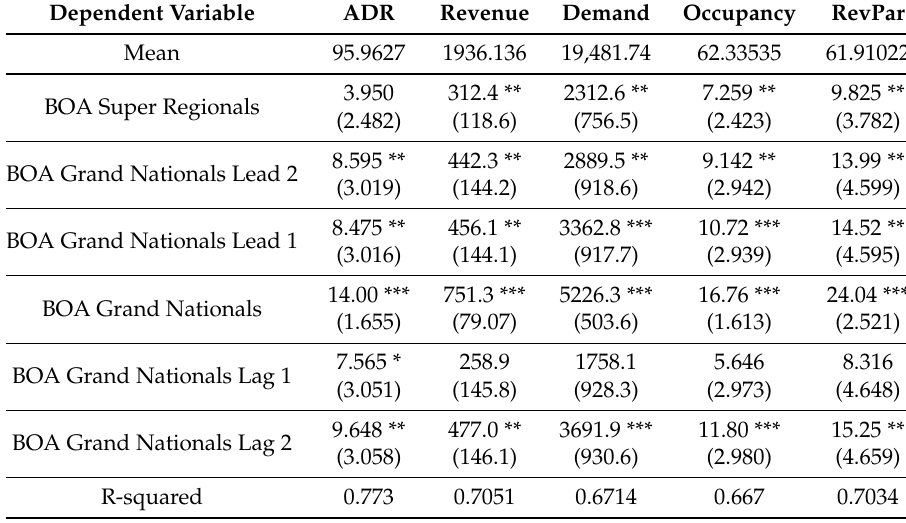
Table 11. The impact of Bands of America (BOA) Super Regionals and Grand Nationals on the hotel industry.